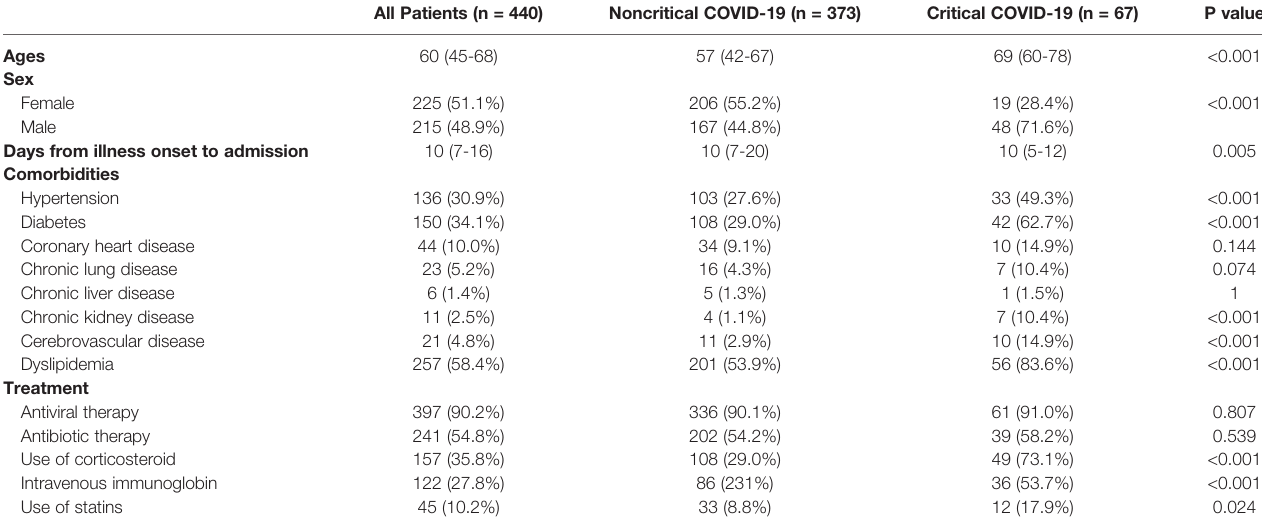
TABLE 1 | Demographics and baseline characteristics of patients with